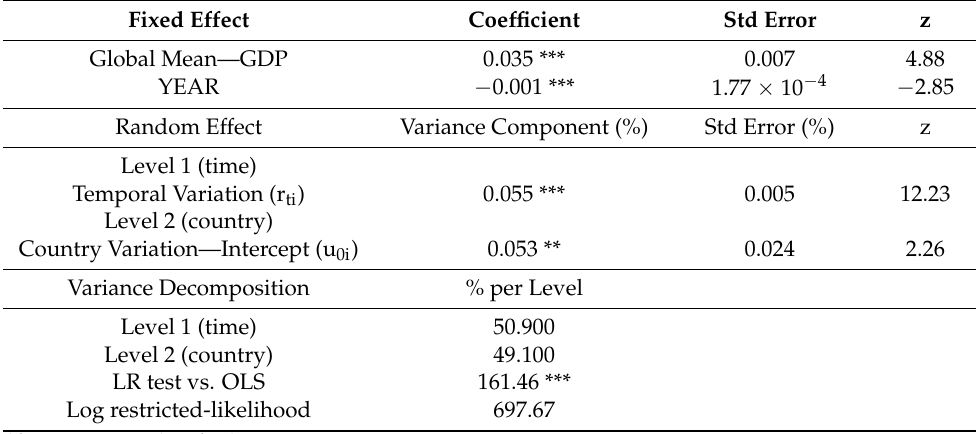
Table 6. Variance Decomposition—Linear Trend Model with Random Intercepts Effects.